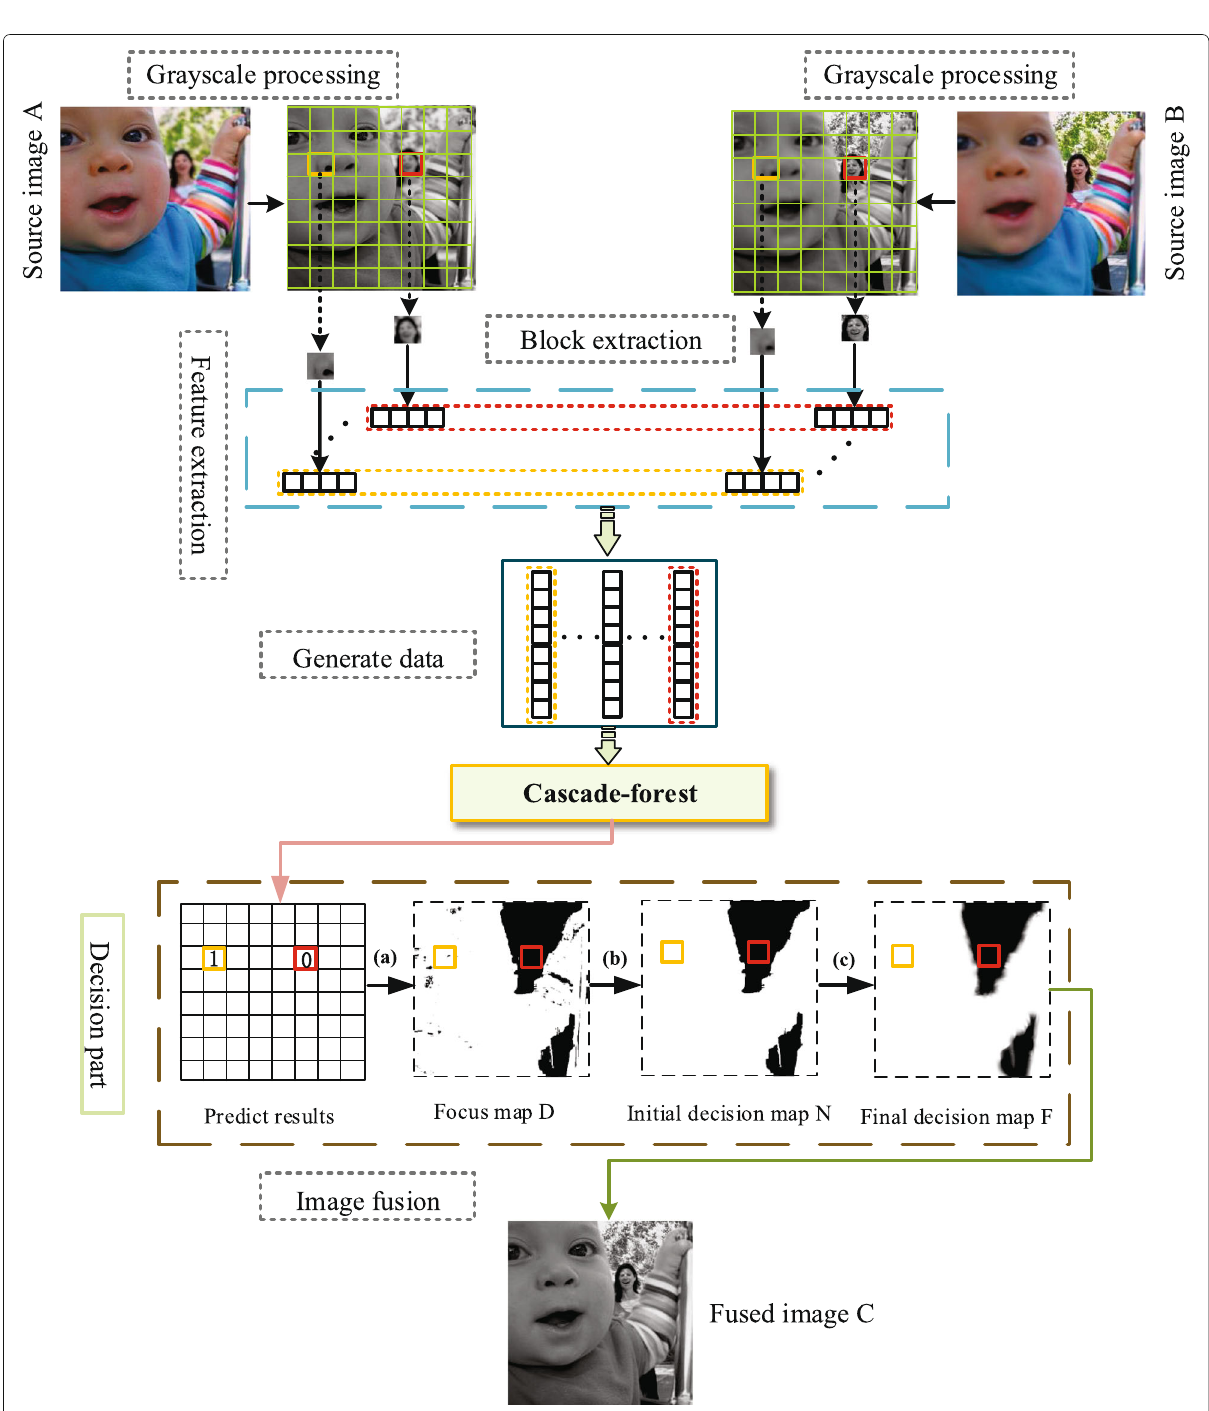
Fig. 3 The schematic drawing of the cascade-forest-based method. a Utilize the predict results to generate the focus map. b Remove noise area less than a certain threshold. c Guide image filtering